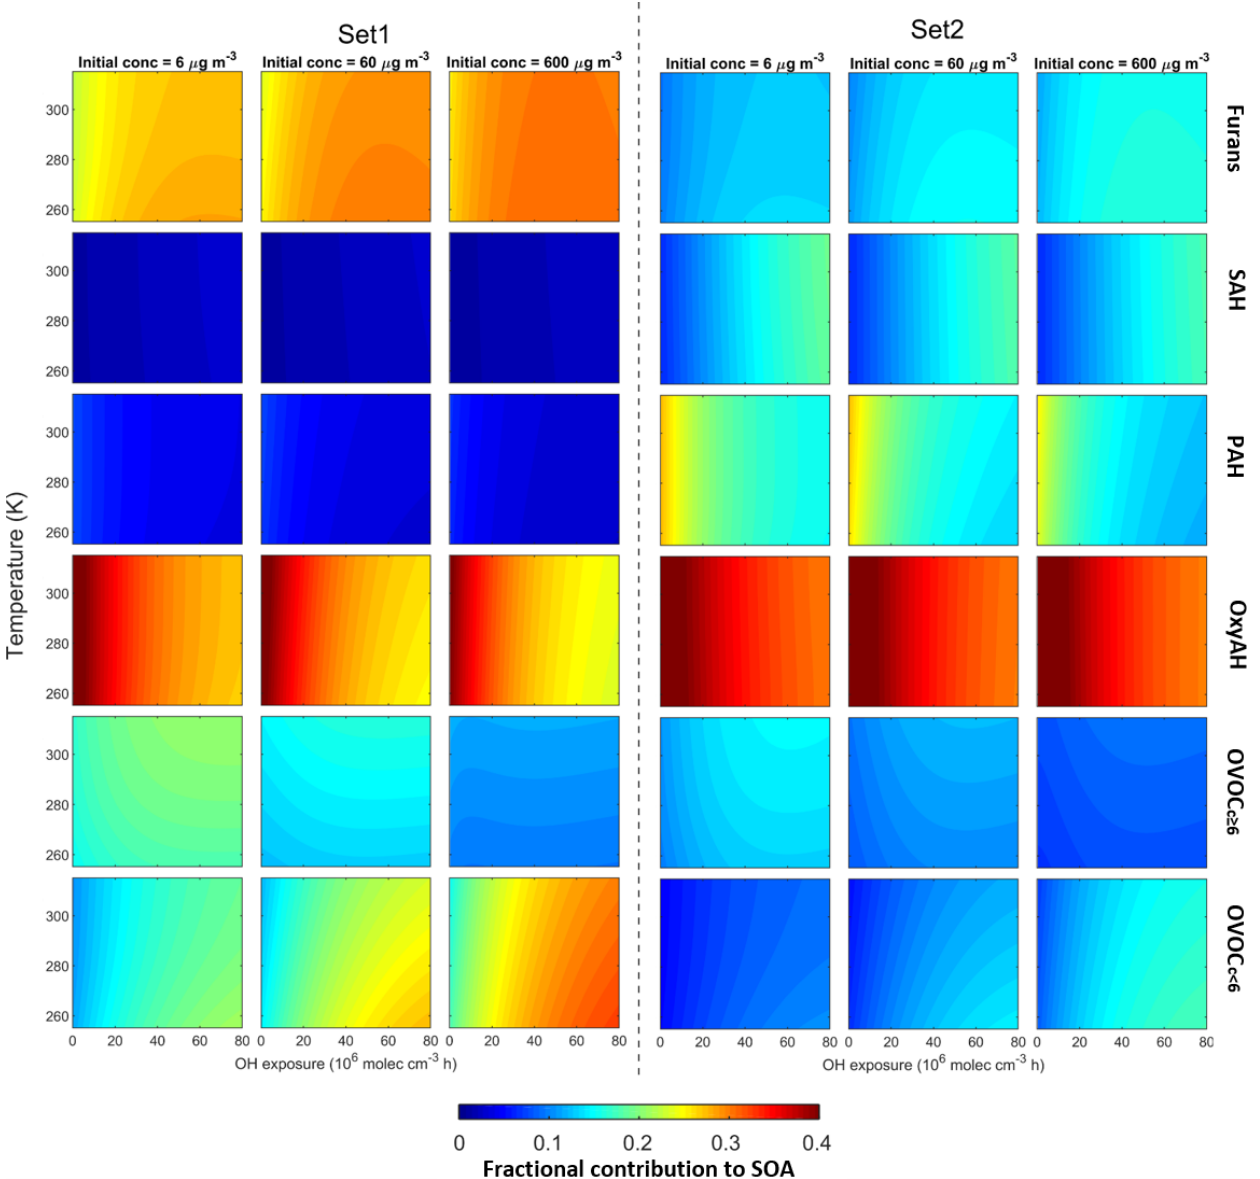
Figure 11. Fractional contributions of the six precursor classes to SOA formation under different temperature, OH exposure and initial OA concentrations. Left and right panels are based on Set 1 and Set 2, respectively. Temperature is provided in kelvin (K) to avoid confusion with the experimental data in degrees Celsius ( ◦